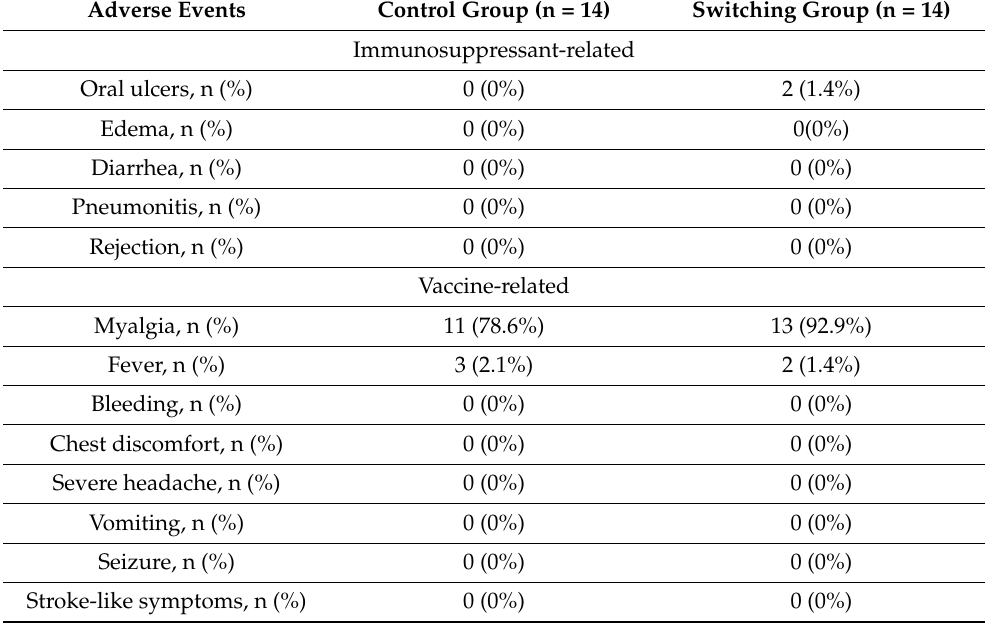
Table 2. Adverse events related to the